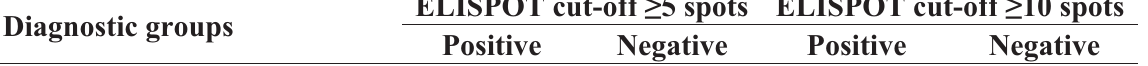
Table 1. Diagnostic performance of ELISPOT-detected Borrelia -induced Interferon-(cid:2) secretion in patients with Lyme neuroborreliosis and non-Lyme neuroborreliosis, utilizing different cut-offs.